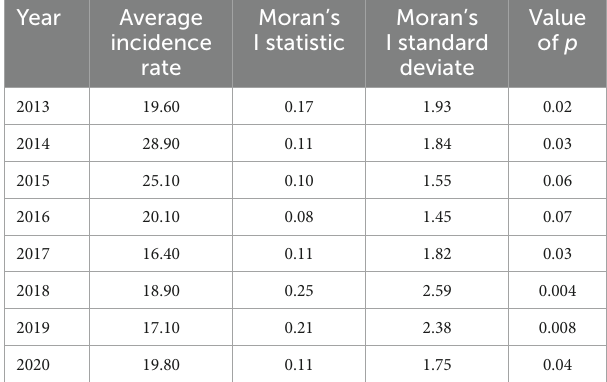
TABLE 6 Annual nationwide cutaneous leishmaniasis average incidence rates/100,000 and investigation of spatial autocorrelation using the Global Moran’I statistic,